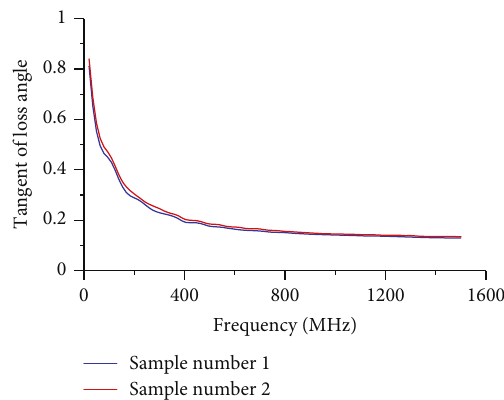
Figure 11: The tangent of loss angular of samples changing with the same water content and compaction level under di ff erent